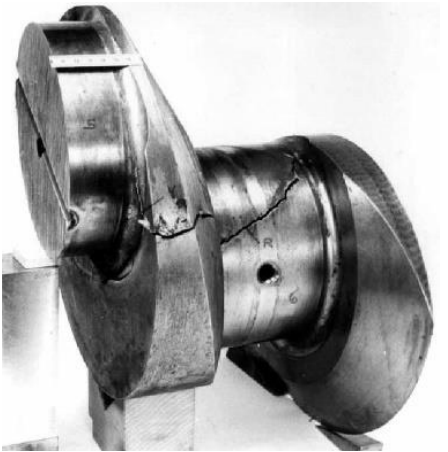
Figure 3. The crankshaft journal damaged by torsional vibration loads [7].